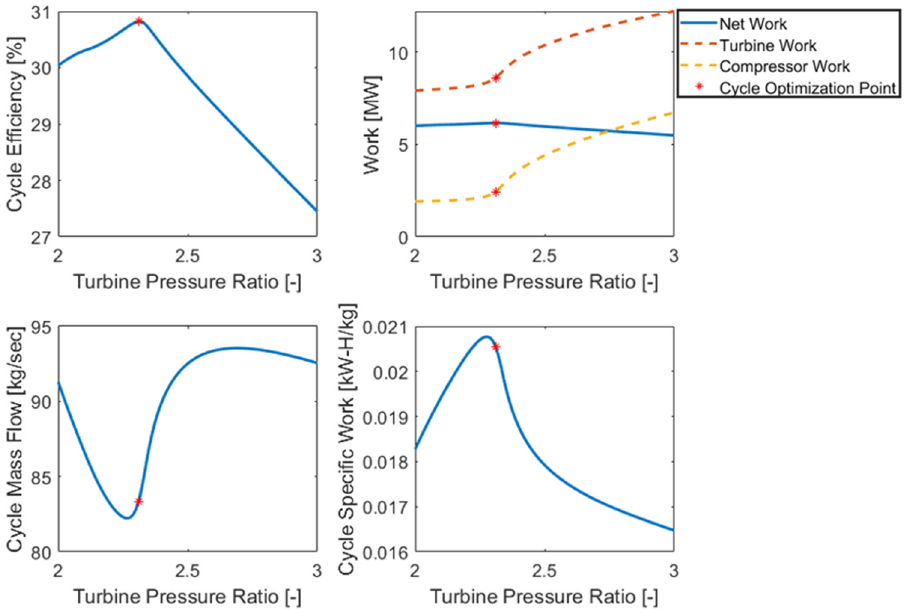
Figure 11. KAIST-CCD Optimization Result for S-CO 2 Brayton Cycle.